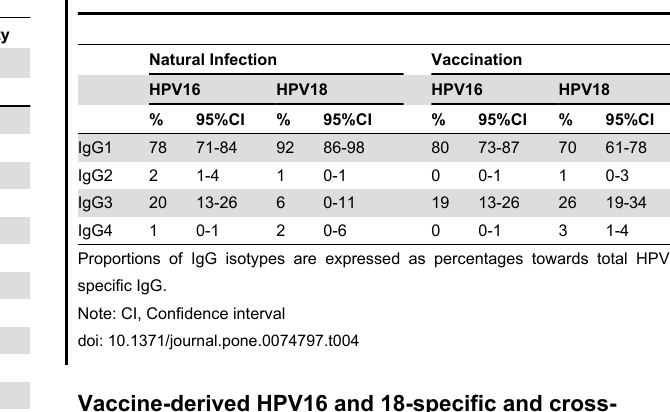
Table 3. HPV-specific antibody characteristics of multi- positive sera induced by HPV infection.